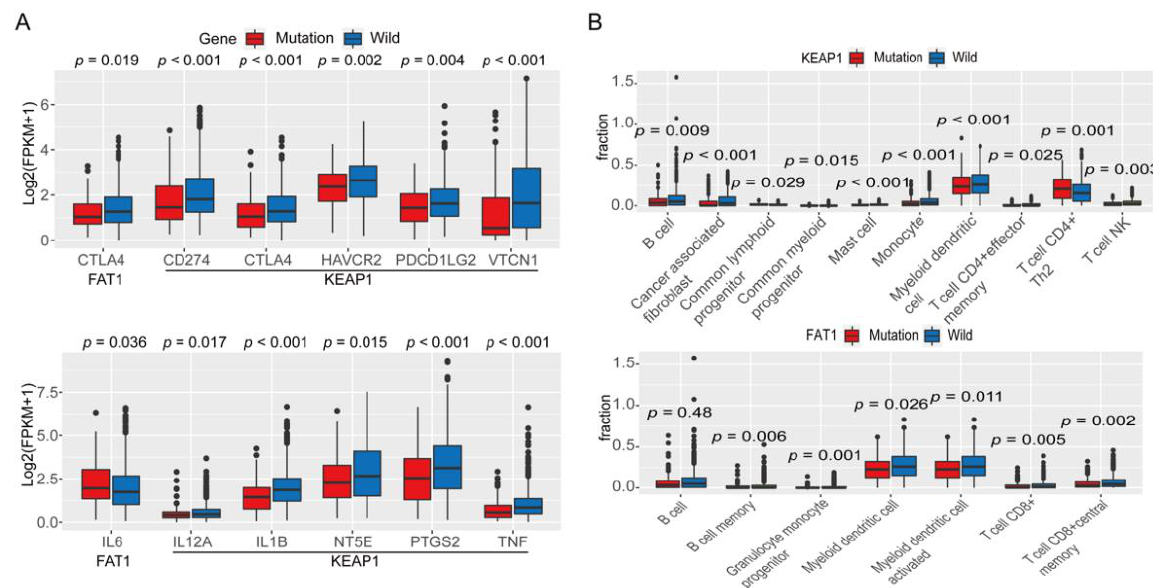
Figure 3. Expression of immune-regulatory genes and status of immune cell infiltration. ( A ) Expression of immune checkpoint genes (upper); status of immune cell infiltration induced by mutation in KEAP1 (lower); ( B ) expression of tumor immune microenvironment genes (upper); status of immune cell infiltration induced by mutation in FAT1 (lower).